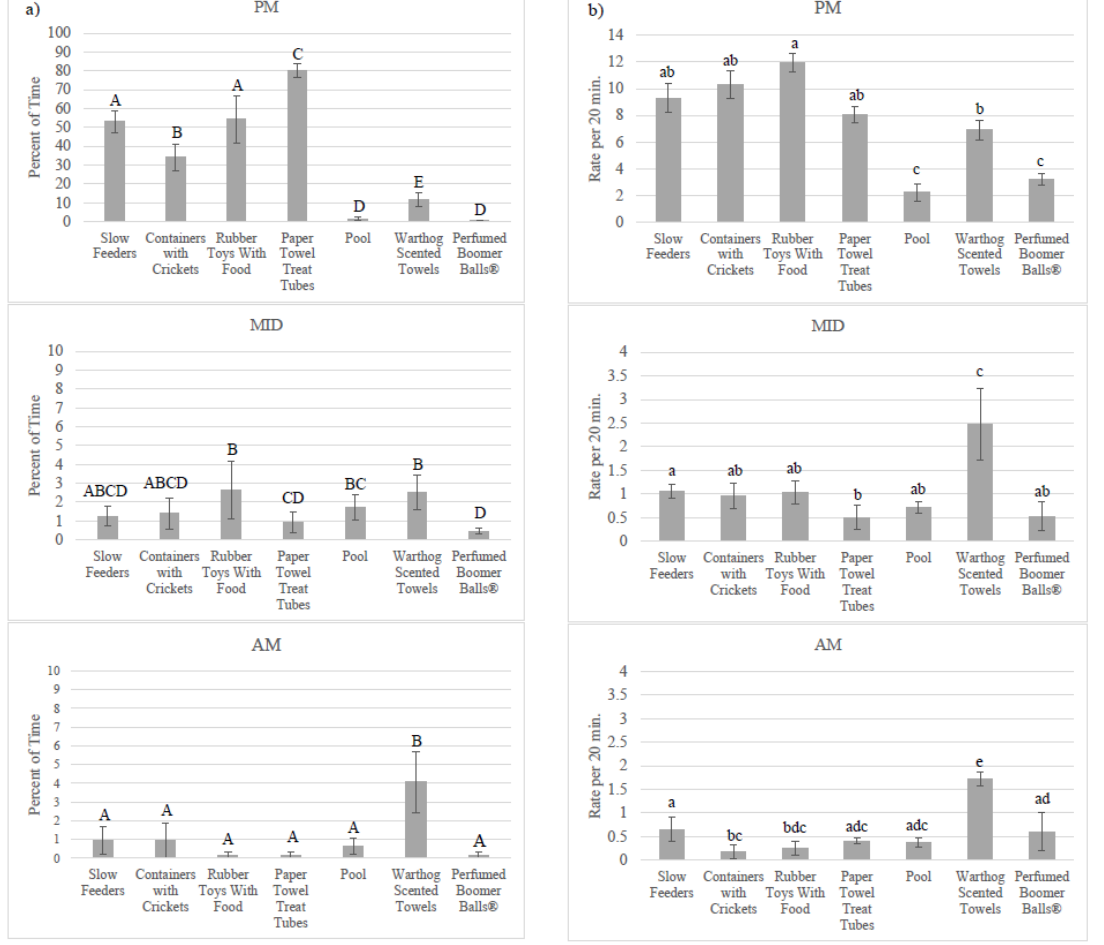
Figure 2. Percent of time spent using enrichment ( a ) and the rate of enrichment use ( b ) for each enrichment item by the time of night (mean ± SE; n = 4). PM observations occurred between 21:00 and 22:00, MID observations occurred between 00:30 and 01:30, and AM observations occurred between 04:00 and 05:00. Significant pairwise comparisons ( p < 0.05) within each timeframe are noted on the graph with different letters, using uppercase letters for percent of time and lowercase letters for rate per 20 min. Note that the scale for enrichment use changes between the PM, MID, and AM graphs. Pairwise comparisons can be found in Table